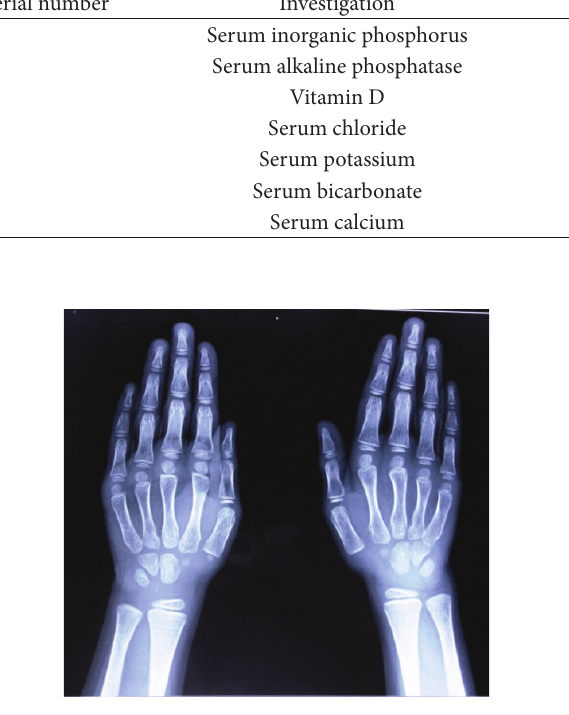
Figure 8: Wrist radiograph.